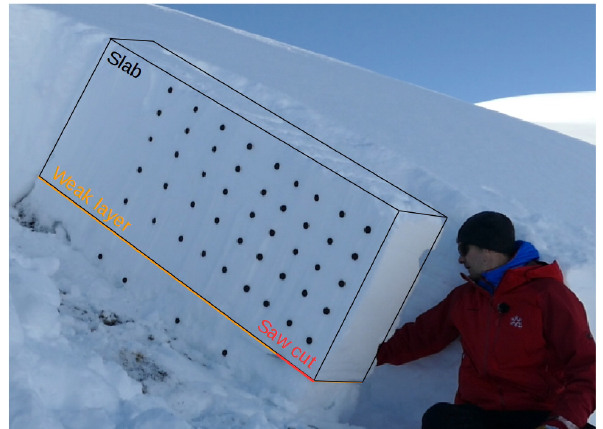
Figure 1. Picture of a propagation saw test (PST). Schematic repre- sentation of the slab (black lines) and the weak layer (orange line). Red line indicates the artificial crack, initiated with a saw. Photo credit Julia Wessels.